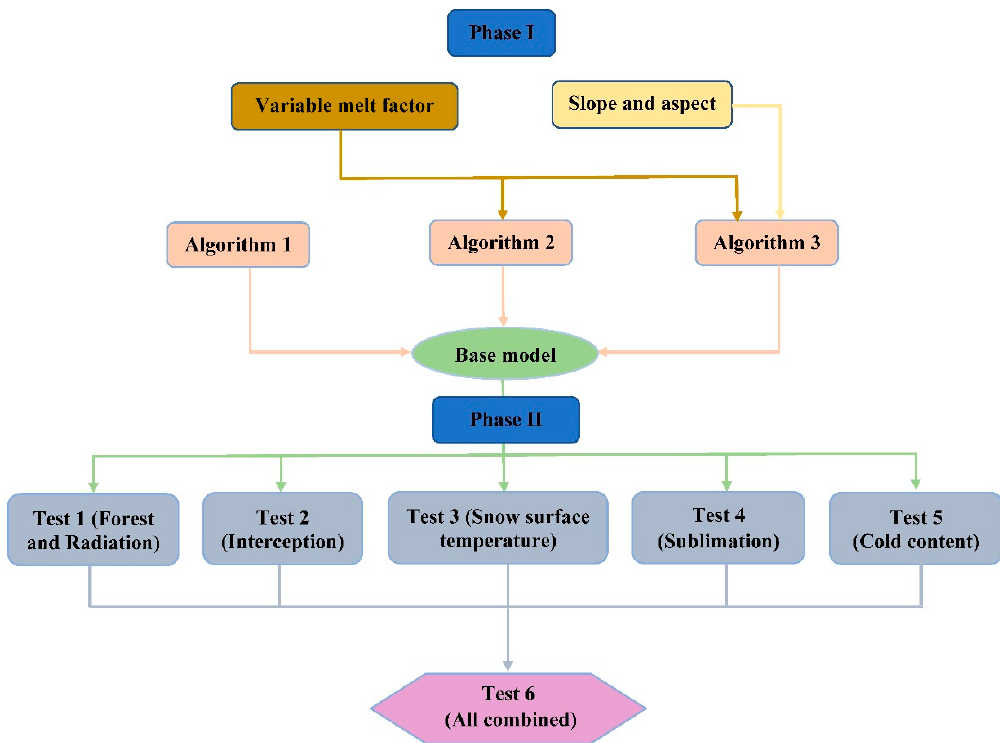
Figure 2. Flow diagram illustrating the experimental design of this study.